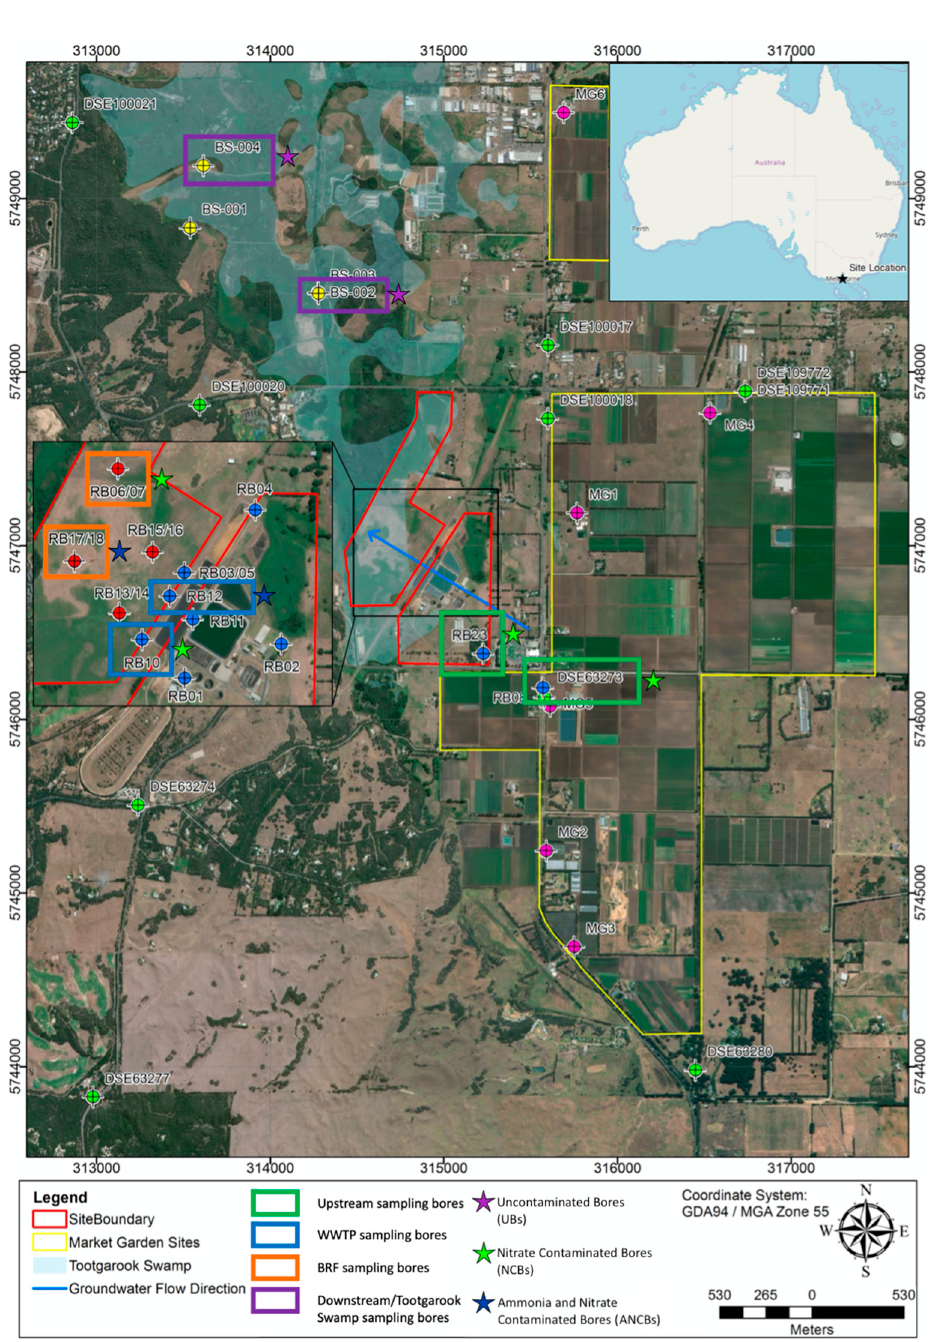
Figure 1. Site location and layout map. BRF = Browns Road Farm.